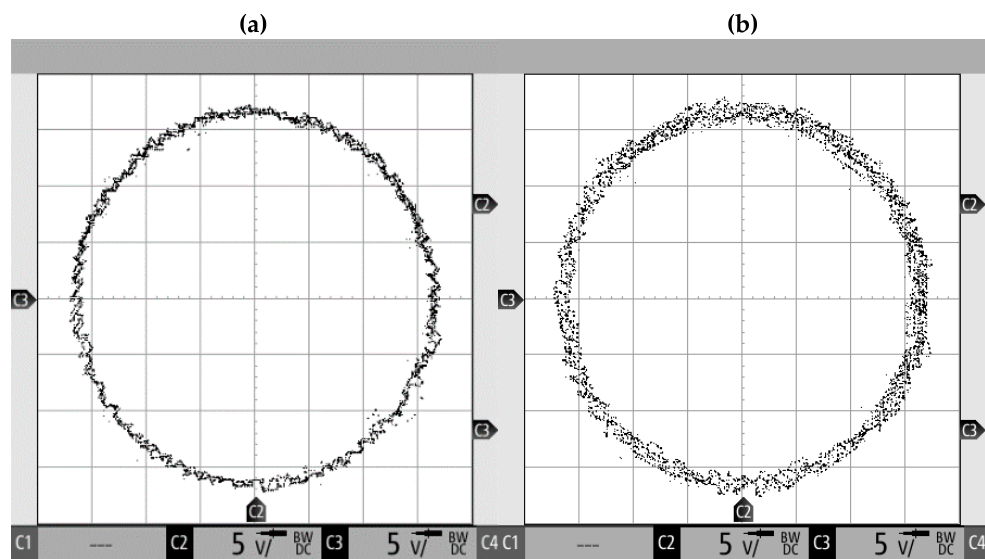
Figure 15. XY chart of the estimated stator flux linkage vector in the stationary αβ coordinate system; reference speed 750 RPM, reference stator flux 1.7 Wb, load torque 0 Nm: ( a ) star-connected winding; ( b ) delta-connected winding.